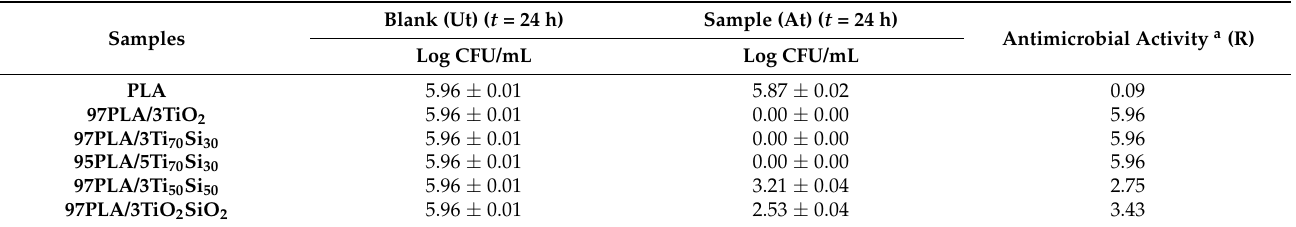
Table 6. Antimicrobial activity of Gram-negative bacteria ( Escherichia coli ) of PLA, PLA/TiO 2 , PLA/Ti x Si y , and PLA/TiO 2 SiO 2